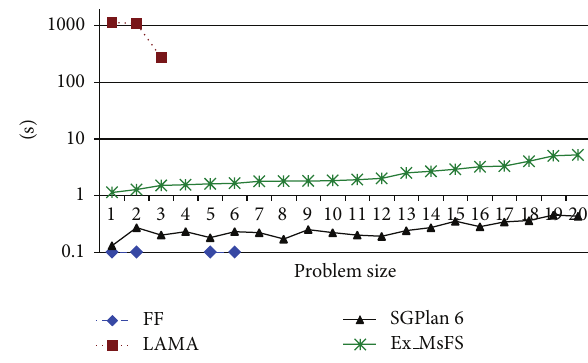
Figure 6: Planning results of the Floortile.